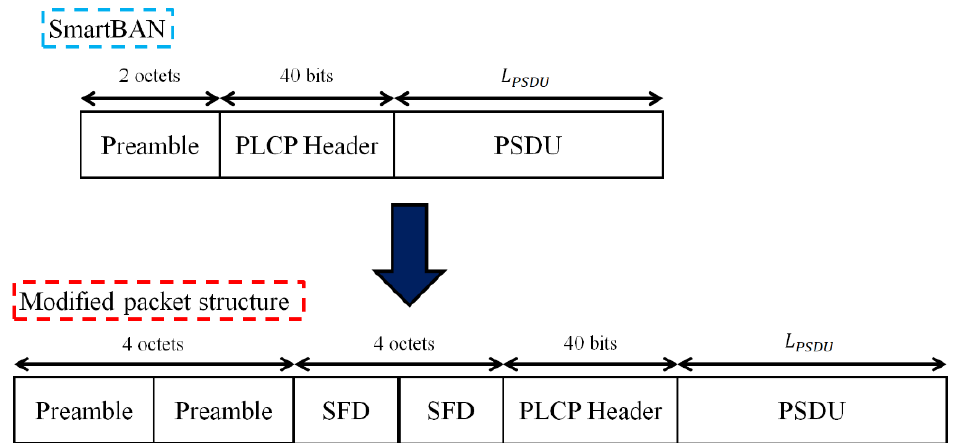
Figure 4. Modified packet structure. The top section of the figure shows the SmartBAN packet structure. The bottom section shows the proposed structure for the case where log 2 𝑀 = 2 .